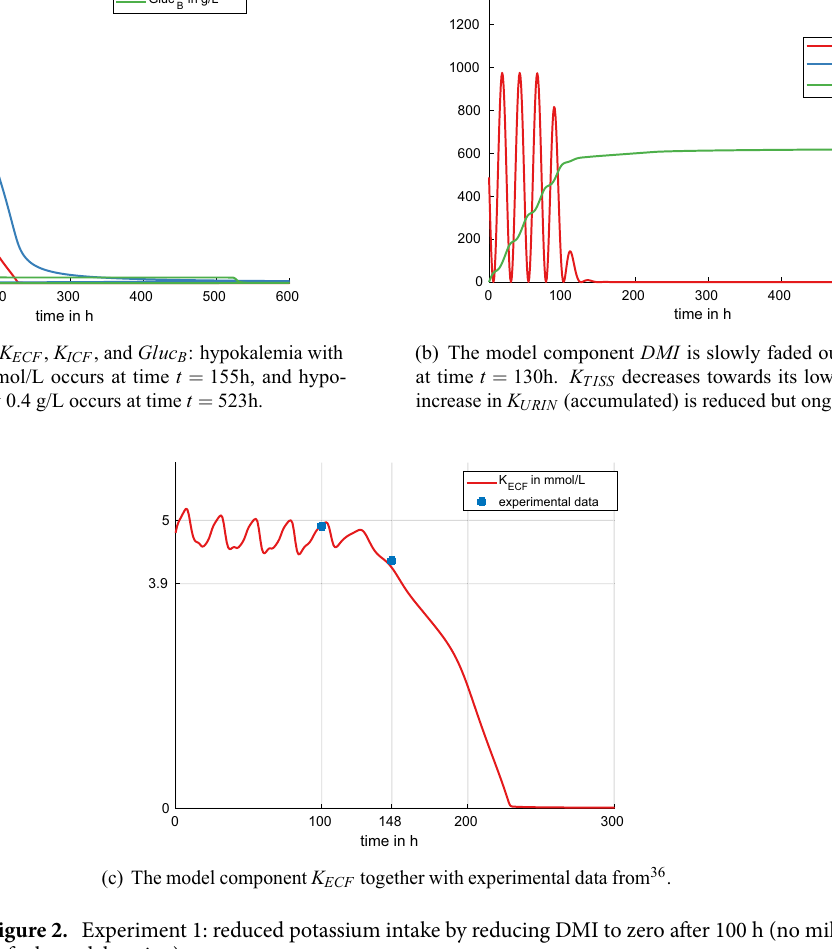
Figure 2. Experiment 1: reduced potassium intake by reducing DMI to zero after 100 h (no milk production, default model setting).